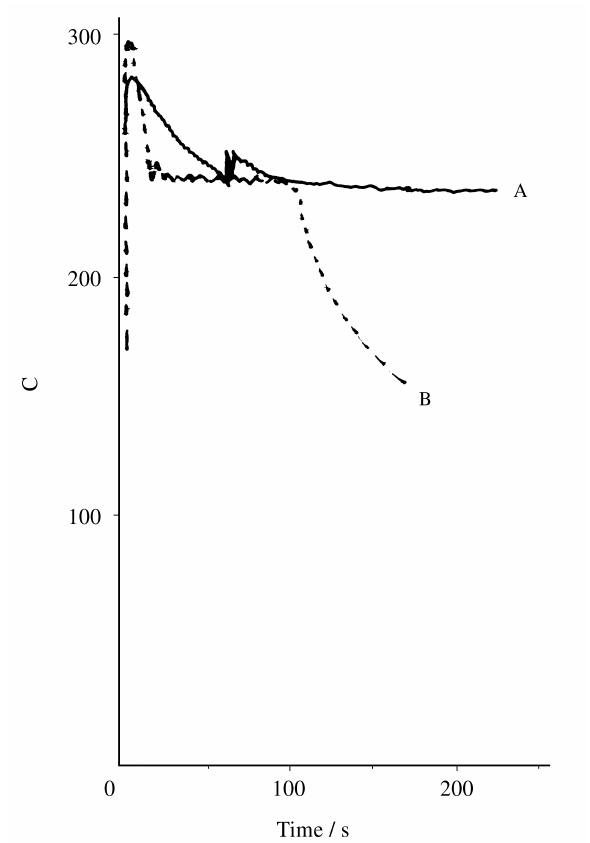
Figure 9. Idem, for molds and thermocouples placed as in Fig. 8 C, D. The recalescences appeared again, without clear arrest temperatures, which can happen when the systems are truly semi-infinte 9 .